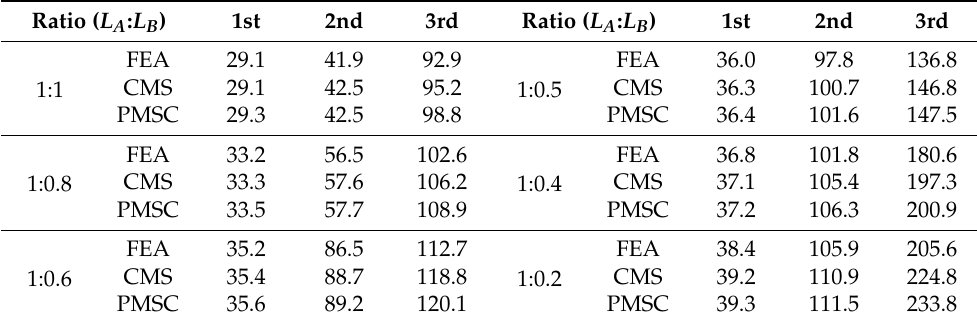
Table 9. Comparison of numerical result